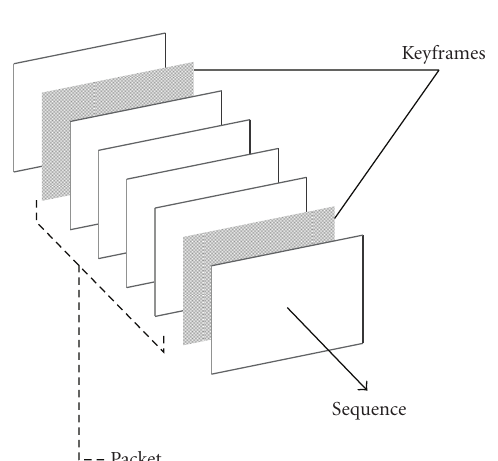
Figure 4: GOP extraction.